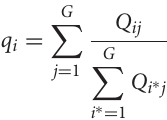
the basic classifier. RF randomly generalizes 1,000 CARTs. Each CART is trained by using samples, where N sample is a total of cell lines. The ultimate